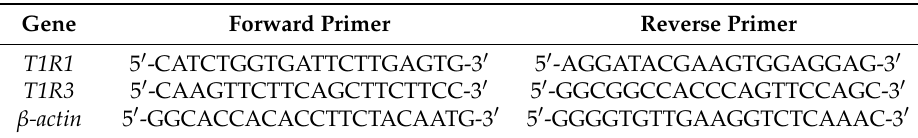
Table 1. Quantitative polymerase chain reaction (Q-PCR)